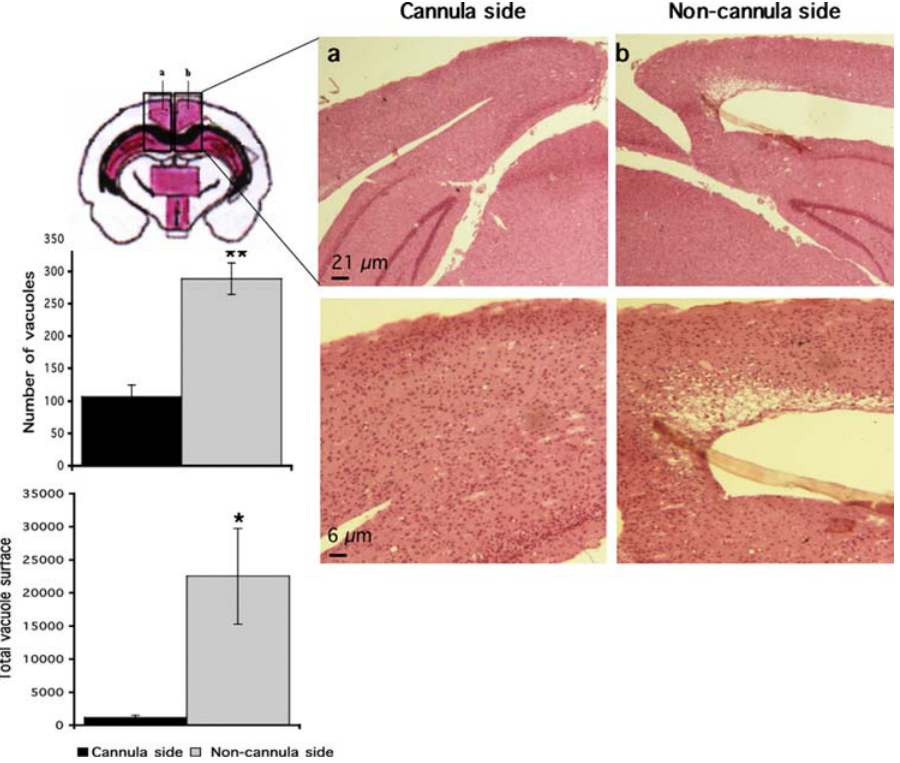
Figure 5. Less spongiosis in the vicinity of the guide cannula in prion-infected mice treated with Y PrPQ167R. Tissue sections were stained with hematoxylin and eosin. Letters a and b on the schema correspond to the secondary visual cortex (SVC) and a part of the hippocampal CA1 region. Bars, 6 m m. Histograms represent either the mean number of vacuoles or the mean total vacuolar surface in the SVC areas. The number of vacuoles was counted in one square of 250,000 m m 2 , corresponding to nearly all the SVC surface, and repeated in three independent sections. The total vacuolar area was determined by drawing the contour of each vacuole present in one square of 2,500 m m 2 using Mercator software (Explora Nova, La Rochelle, France), which was repeated in three independent sections from the same mouse. The histograms represent the means 6 s.e.m. Statistical analysis was performed using STATVIEW 5 software. Values were analyzed by ANOVA followed by the PLSD Fisher test (n=3). The number of vacuoles in the treated side was statistically different from the non-treated area (**, p , 0.005). The total vacuolar area in the cannula side was statistically different from that in the non-cannula side (*, p , 0.05). doi:10.1371/journal.pone.0002773.g005 rate of GFAP staining (Figure 7D). Estimating the number of GFAP-positive cells with the Mercator software confirmed the histological results. For instance, only 1.8 6 0.5 GFAP positive cells/ 10,000 m m 2 were counted in healthy mice treated with Y PrPQ167R, while 127 6 11 and 136 6 10 GFAP-positive cells/